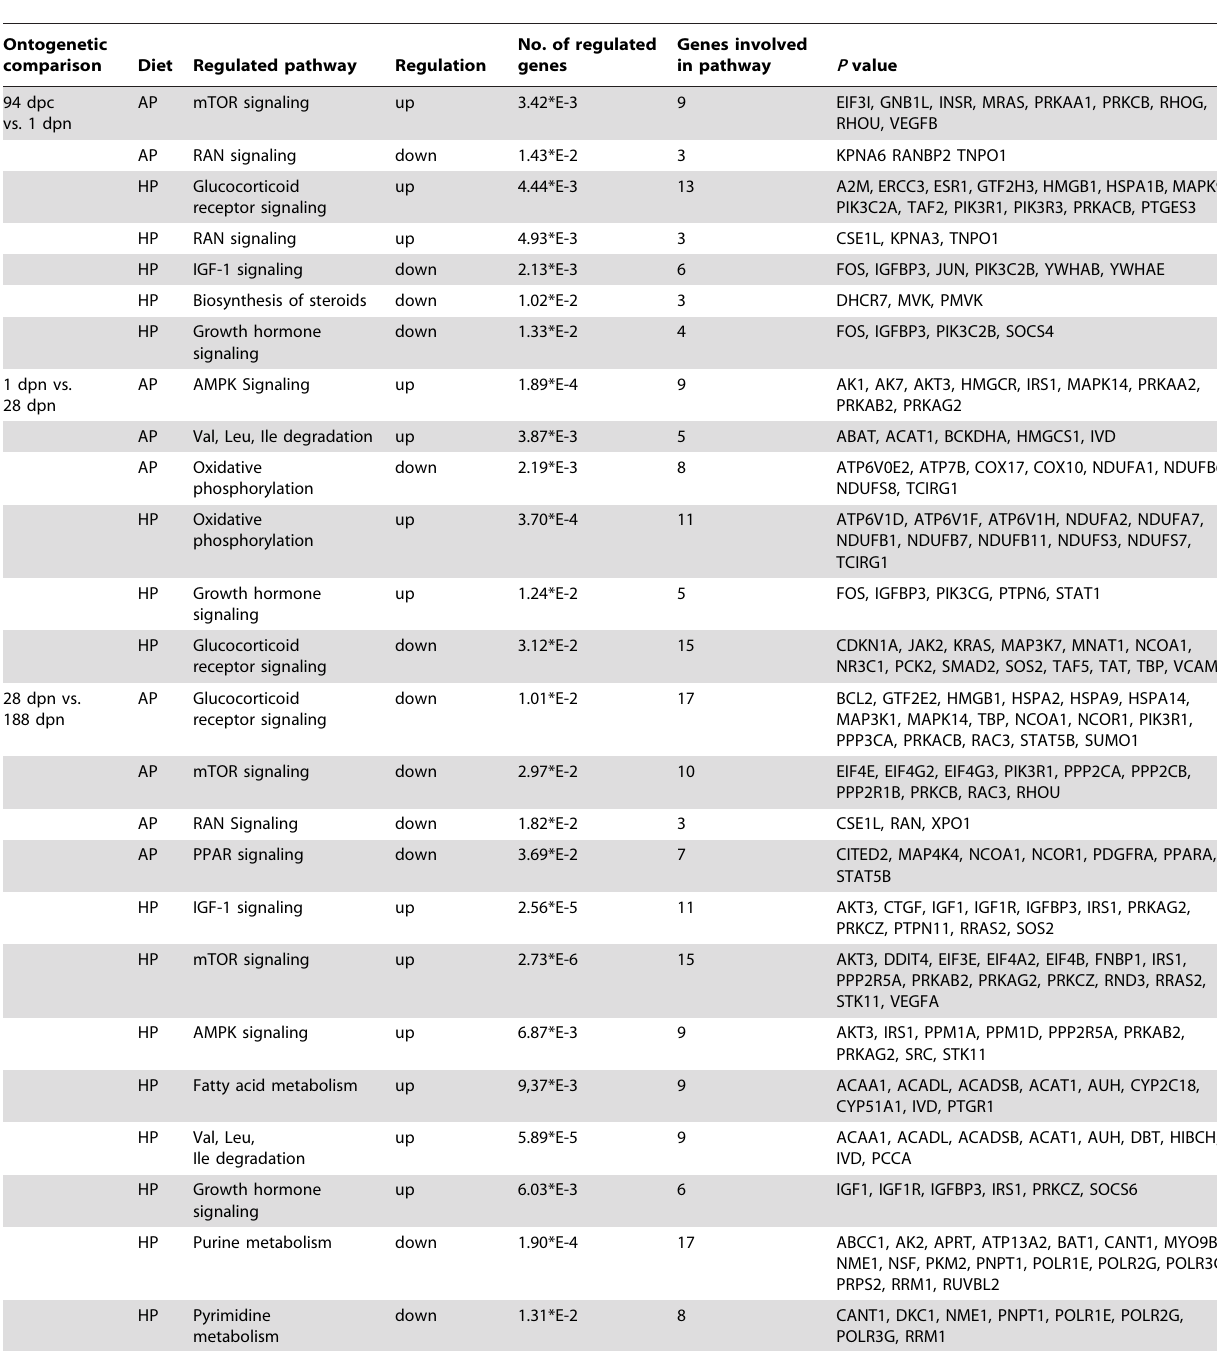
Table 2. Significantly regulated transcripts of metabolic pathways in liver tissue between two ontogenetic stages within one dietary group (Ingenuity Pathway